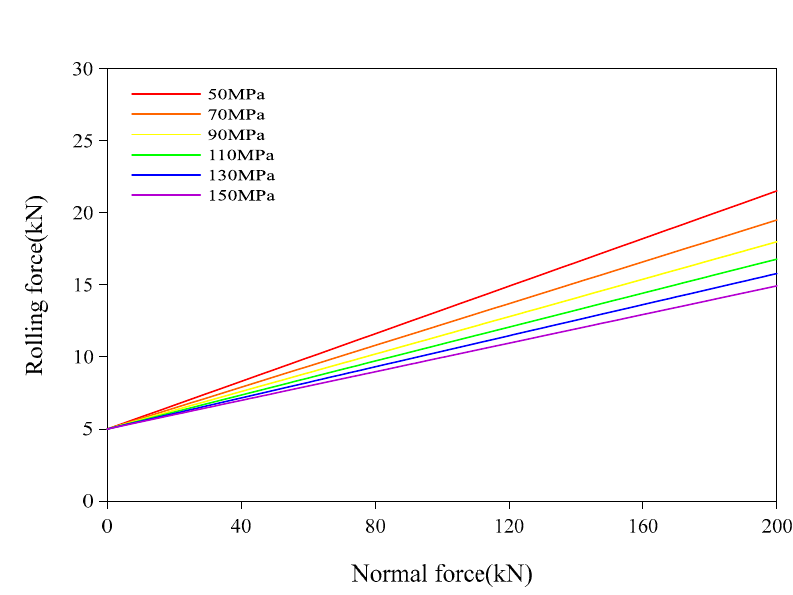
Figure 12. Relationships between normal and rolling forces suggested in this study.